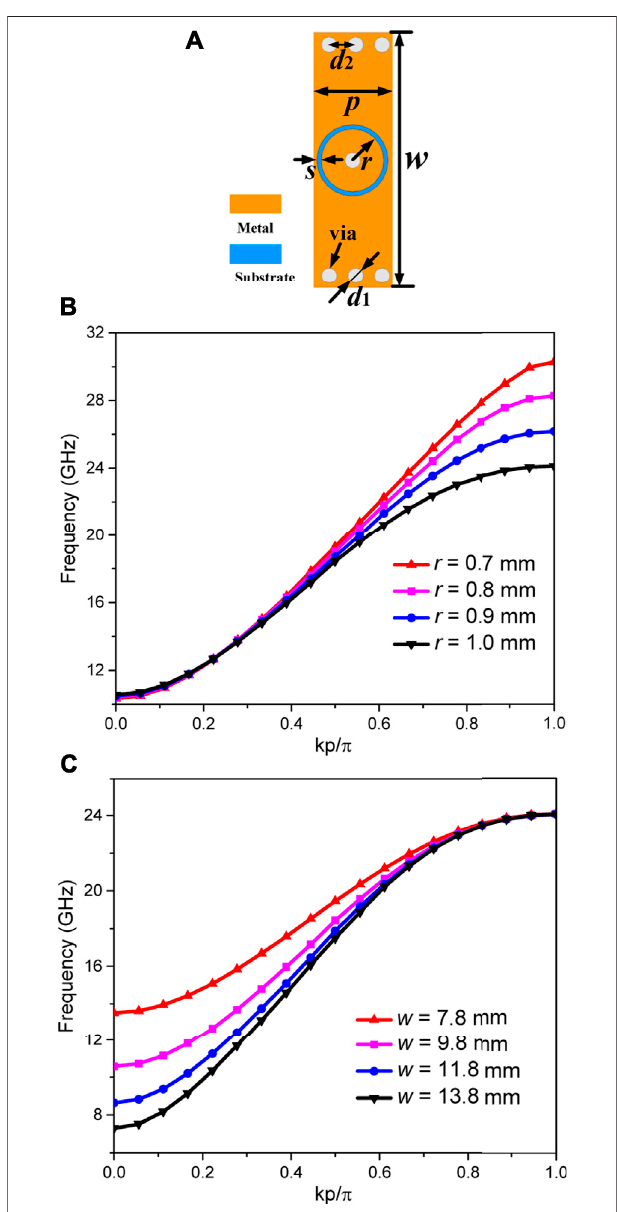
FIGURE 1 | (A) Schematic con fi guration of the proposed SSPP unit cell and its dispersion curves with different values of (B) parameter r and (C) parameter w